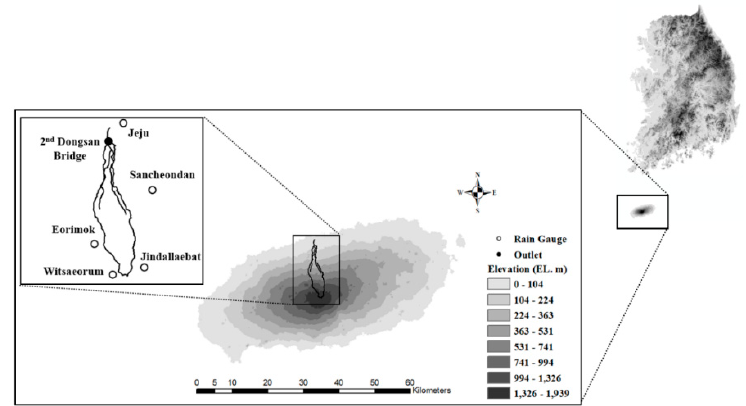
Figure 2. Location of the Hancheon basin in the Jeju Island, Korea (the empty circle represents the rain gauge and the solid circle the stage gauge at the exit of the basin).